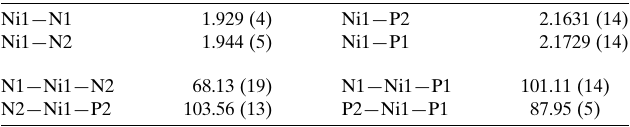
Table 3 Experimental details. Crystal data Chemical